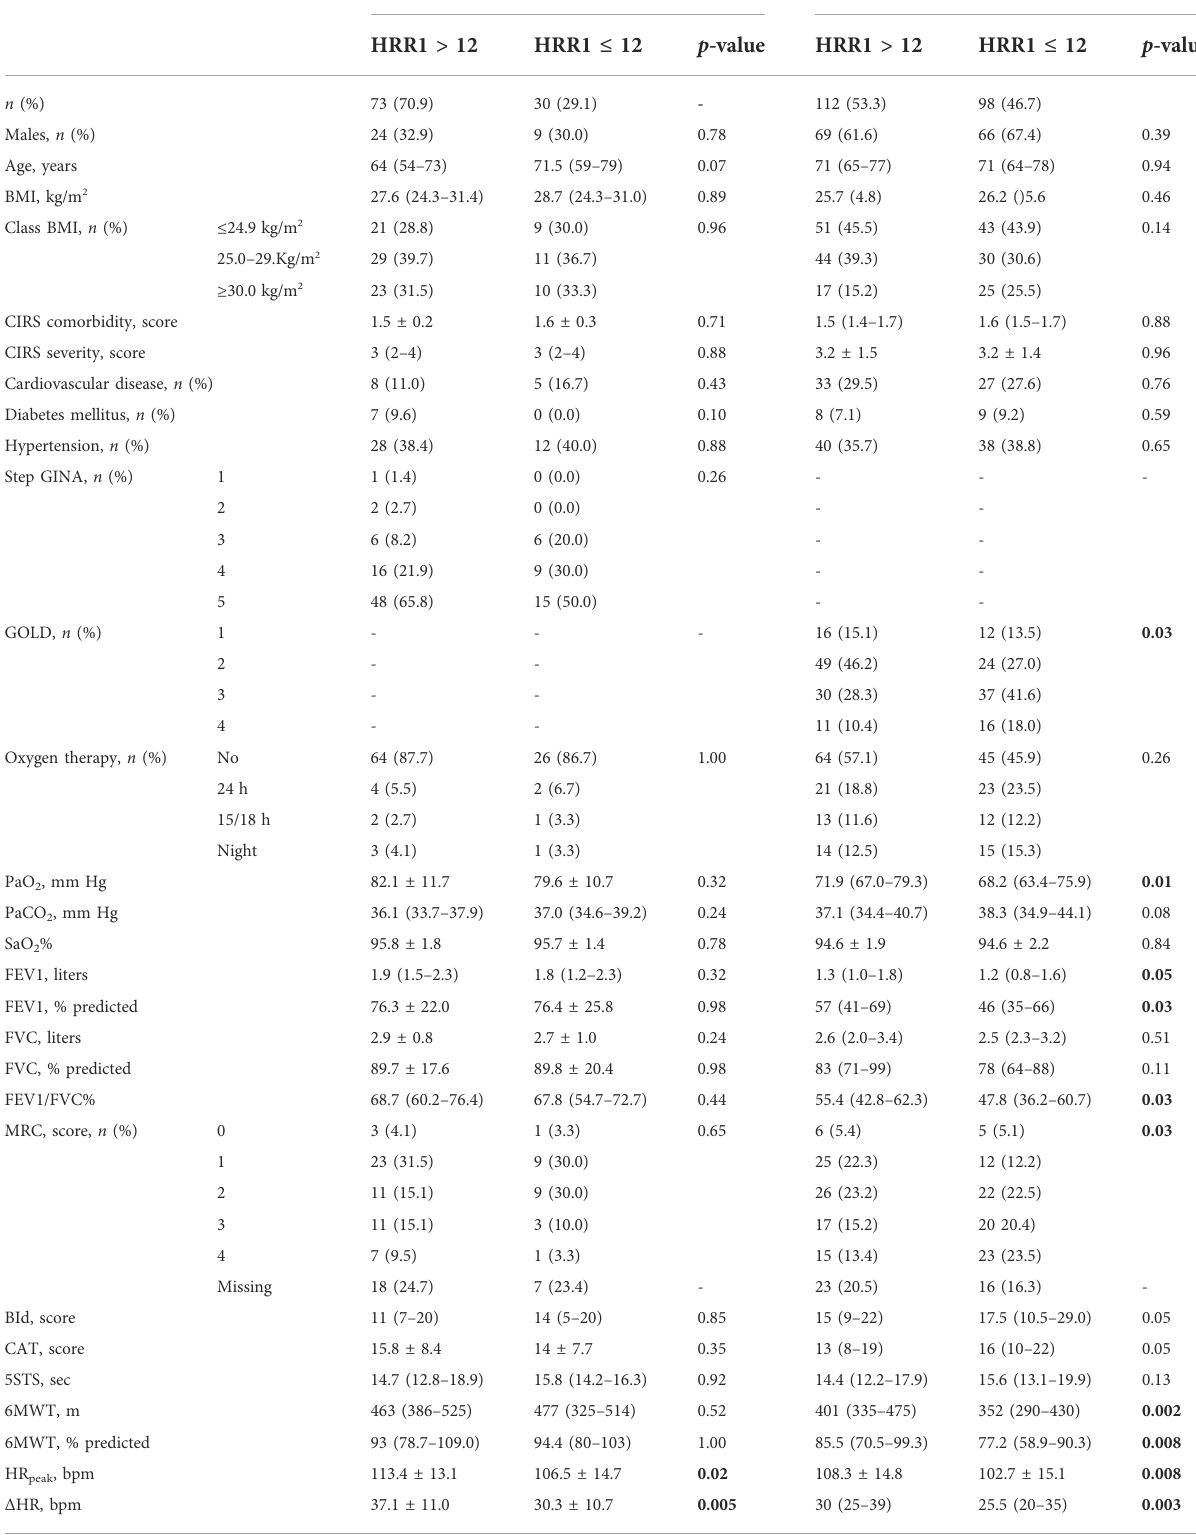
TABLE 2 Baseline characteristics according to